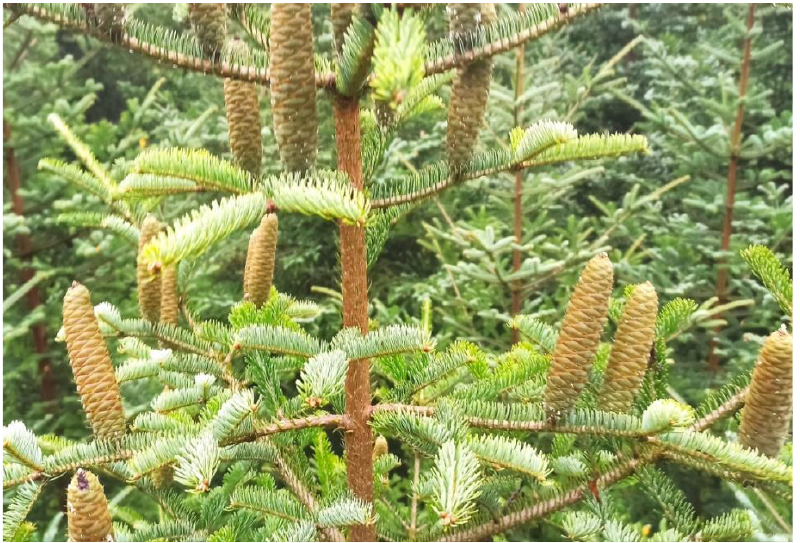
Figure 3. Fruiting of individual trees on plot No. 1 of the half-sib silver fir plantation in 2021 (photo by K. Wilamowski).